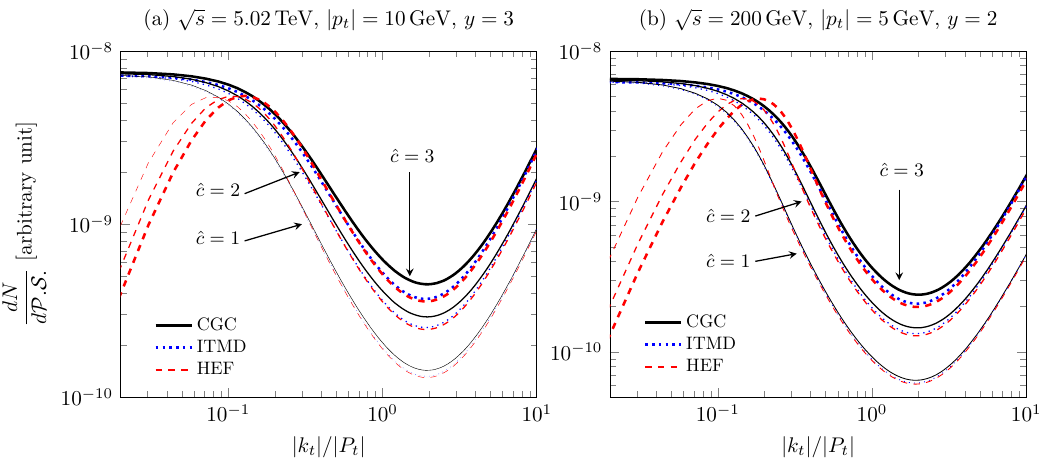
Figure 13 . Dijet production yield vs. | k t | / | P t | obtained in the CGC (black solid), ITMD (blue dotted), and HEF (red dashed) framework at | p t | = 20 GeV (a) and 10 GeV (b) with y = 3 and √ s = 5 . 02 TeV fixed. Line thickness represents the nuclear dependence: ˆ c = 3 (very thick), ˆ c = 2 (semi thick), ˆ c = 1